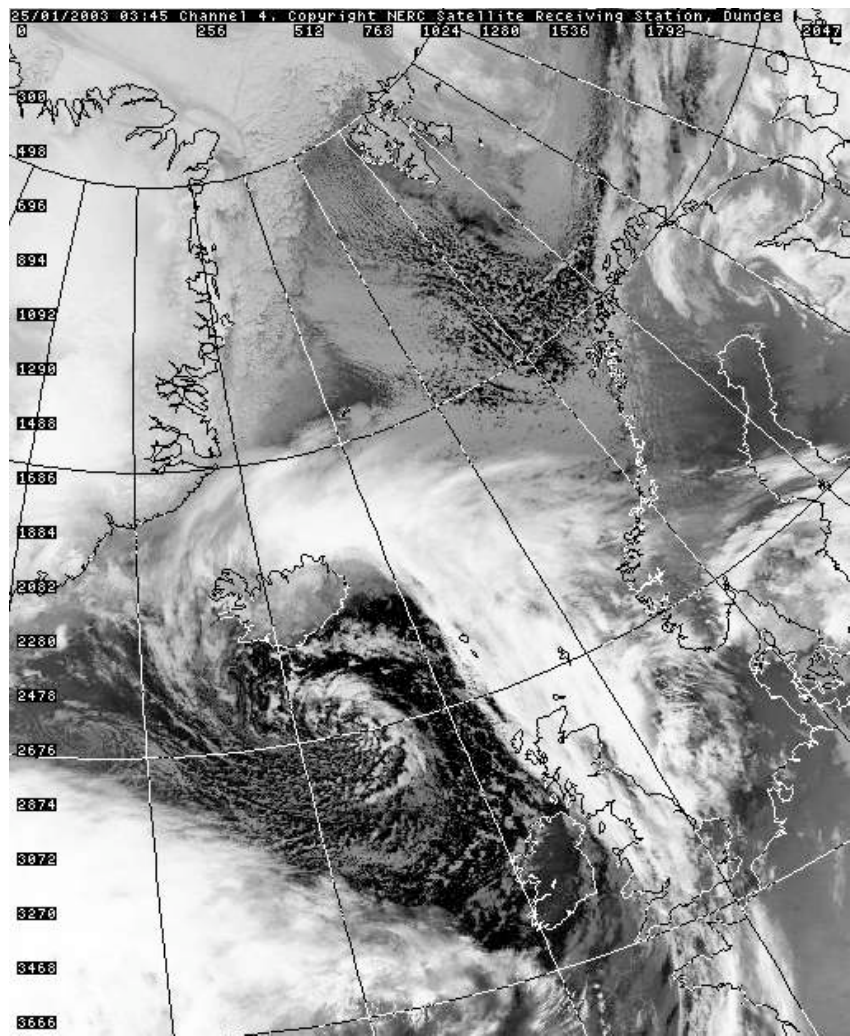
Fig. 3. Satellite cloud image at 03:45UT on 25 January 2003 (NOAA, IR channel 4 from